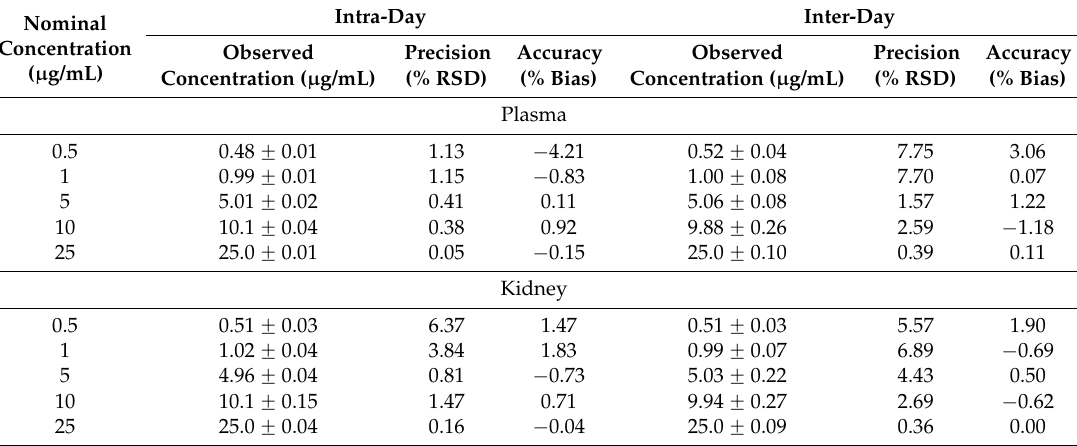
Table 1. Intra- and inter-day precision (% RSD) and accuracy (% Bias) of the HPLC-PDA method for